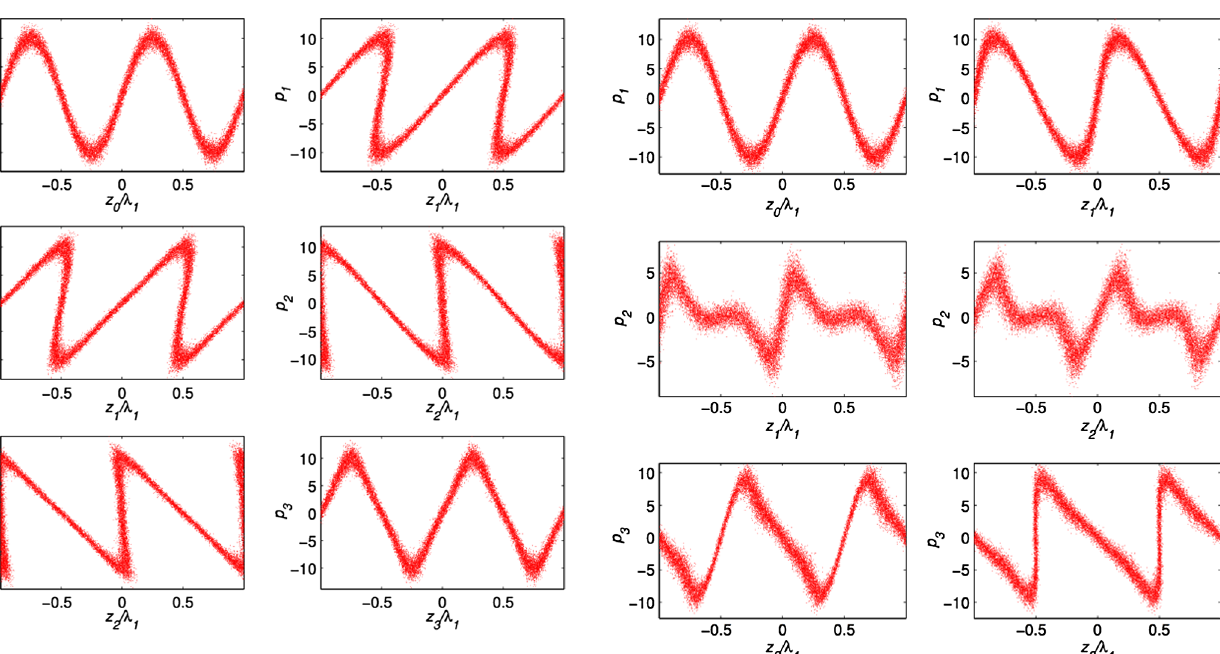
FIG. 4. Synthetic triangle or sawtooth wave generation with three modulations of wavelength (cid:6) 1 . The initial modulation (top left) is weakly dispersed in the first chicane (top right). Compensation of the curvature takes place in the second modu- lator (middle left). Reversing the dispersion (middle right) then enables correction of the remaining portion in the third modulator (bottom left). The last dispersion section sets the final waveform shape (bottom right). Here A 1 ¼ 10 , A 2 ¼ A 1 = 16 , A 3 ¼ A 2 , B 1 ¼ (cid:1)= 2 A 1 , B 2 ¼ (cid:1) 2 B 1 , B 3 ¼ (cid:1) B 2 = 2 , (cid:3) 2 ¼ (cid:1) , and (cid:3) 3 ¼ (cid:1) . (cid:3) 2 ¼ (cid:1) prevents excitation of even powers of the curvature.